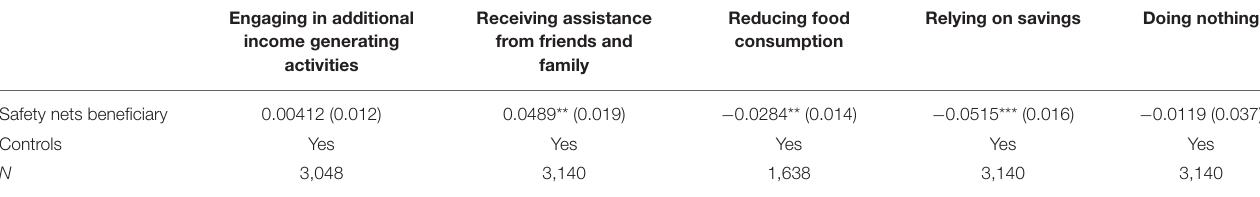
TABLE 6 | Central region regression results on safety nets.